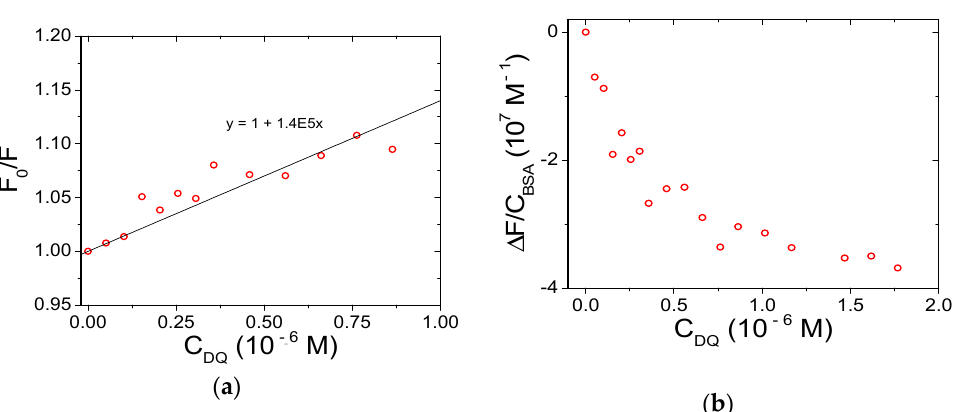
Figure 7. Spectrofluorimetric titration for the DQ/BSA system: ( a ) Stern–Volmer plot; ( b ) binding isotherm; C BSA = 1.50 × 10 − 6 M, NaCl 0.1 M, NaCac 2.5 mM, pH 7.0, 37.0 °C, λ ex = 295 nm, λ em = 345 nm.